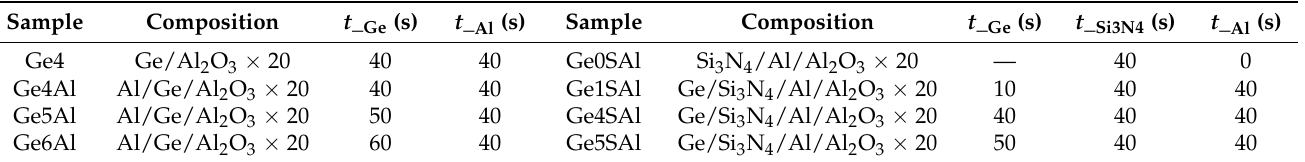
Table 1. Deposition parameters of the produced thin films (left: first series, right: second series); t denotes the deposition time. The deposition time for Al 2 O 3 in each layer was 200 s for all